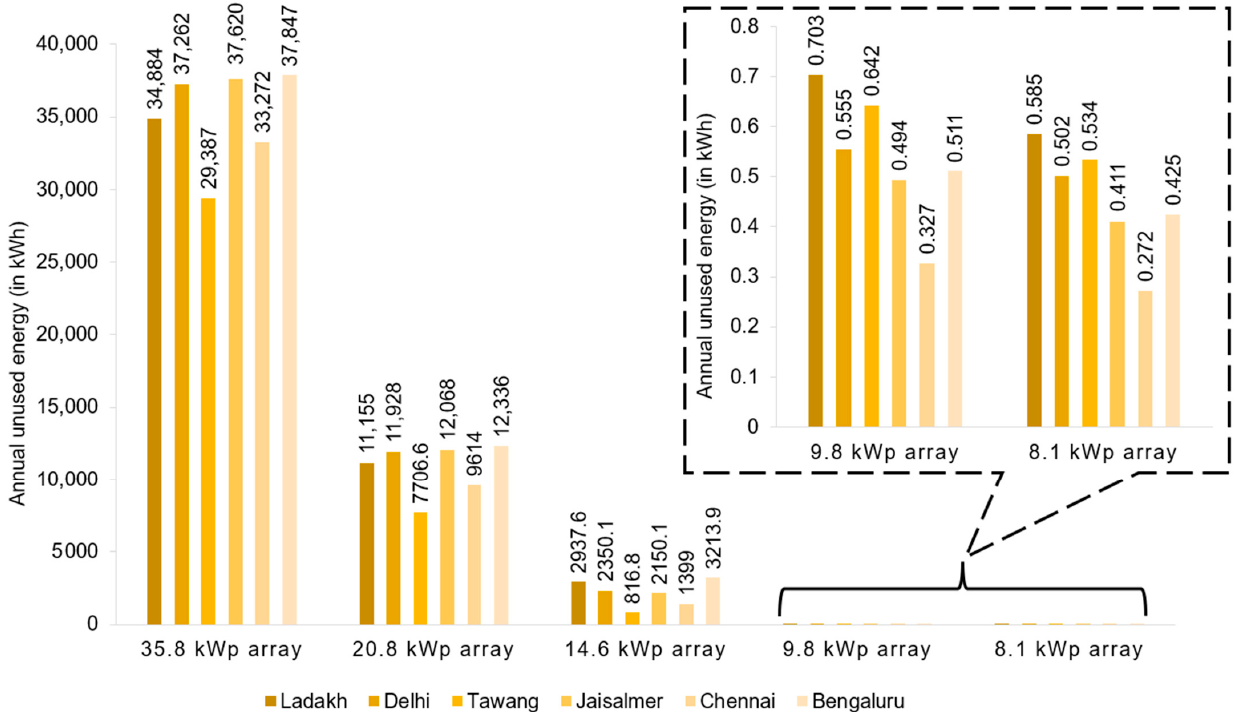
Figure 9. Annual unused energy for different array capacities in all six cities.